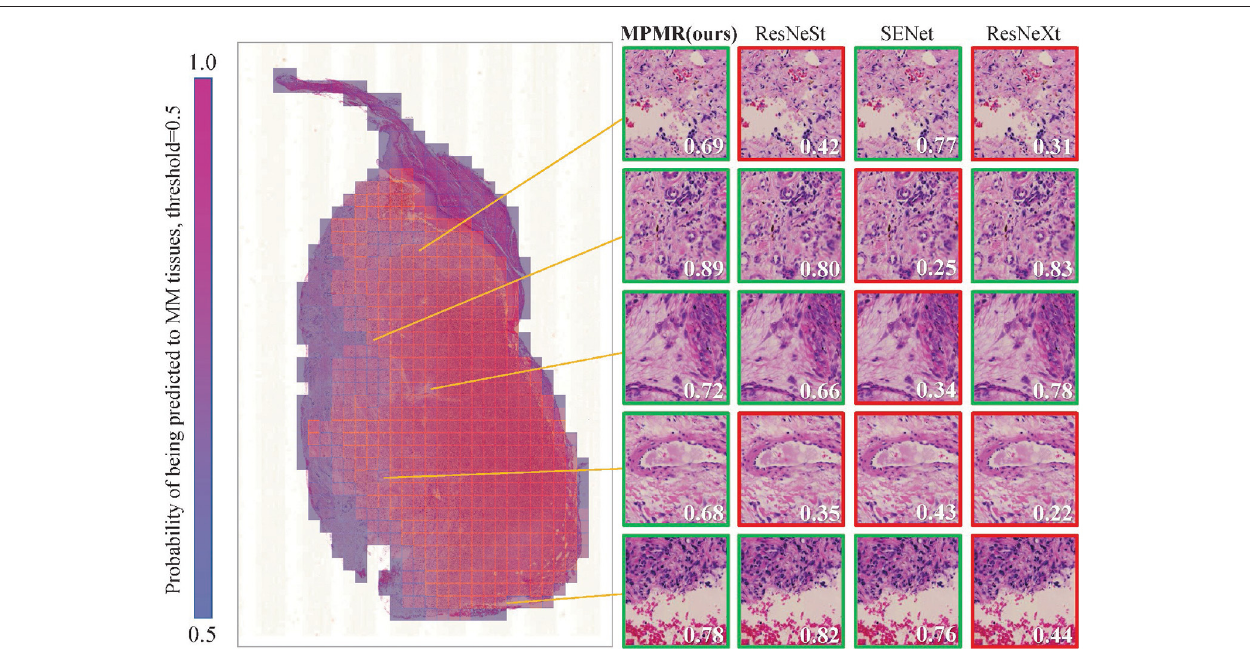
FIGURE 5 | The mosaic-style mask result of a WSI in the test dataset is generated through the probability map obtained through patch image classification. The recognition results of some patches, which are difficult to recognize, through different algorithms are compared. A green box represents a correct prediction, and a red box represents a misclassification. The probabilities of being predicted as MM tissues are marked in each patch image, and the threshold is 0.5.